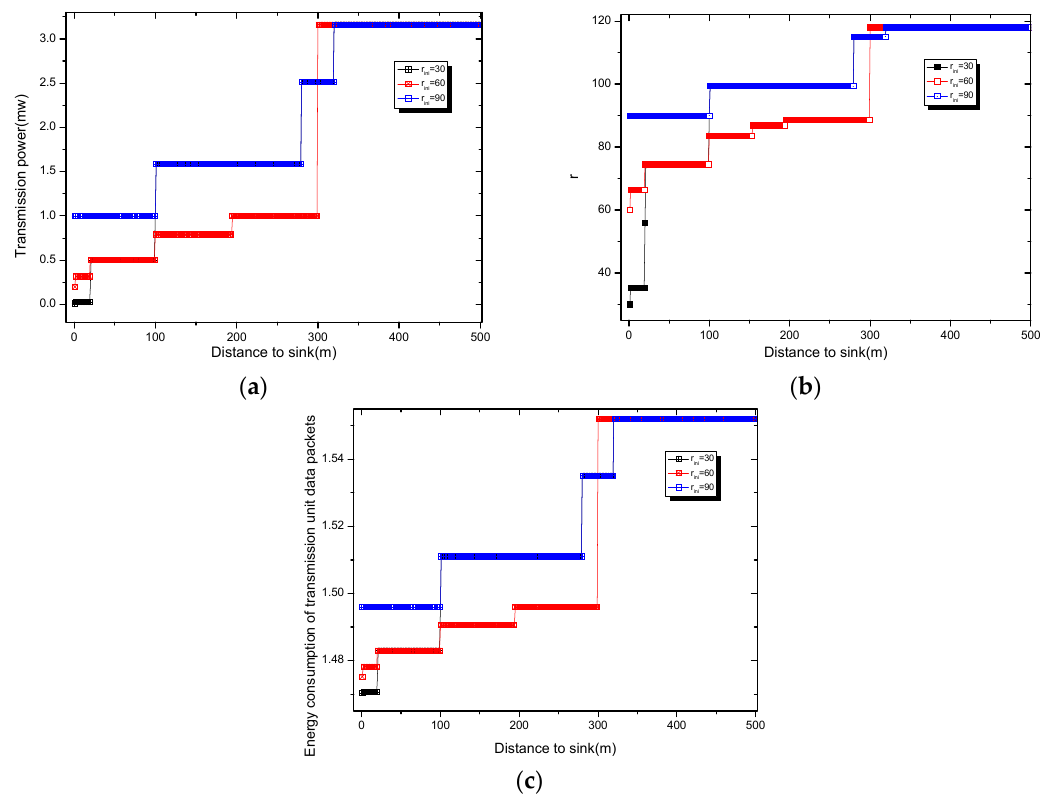
Figure 12. ( a ) Transmission power at different distances from sink; ( b ) broadcast radius at different distances from sink; ( c ) energy consumption of transmission unit data packets.